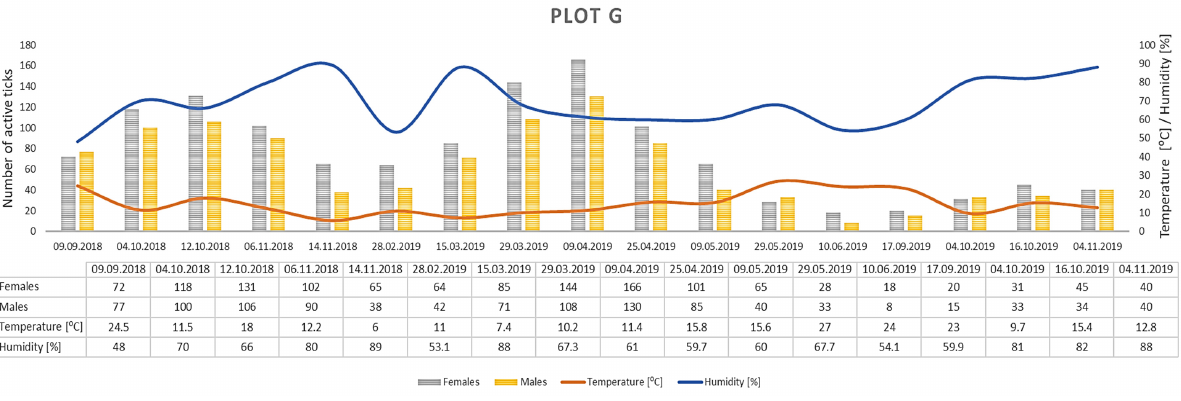
Figure 9. Abundance and seasonal activity of Dermacentor reticulatus adults in research plot G and weather conditions prevailing during tick collection. Predominance of active ticks in autumn.